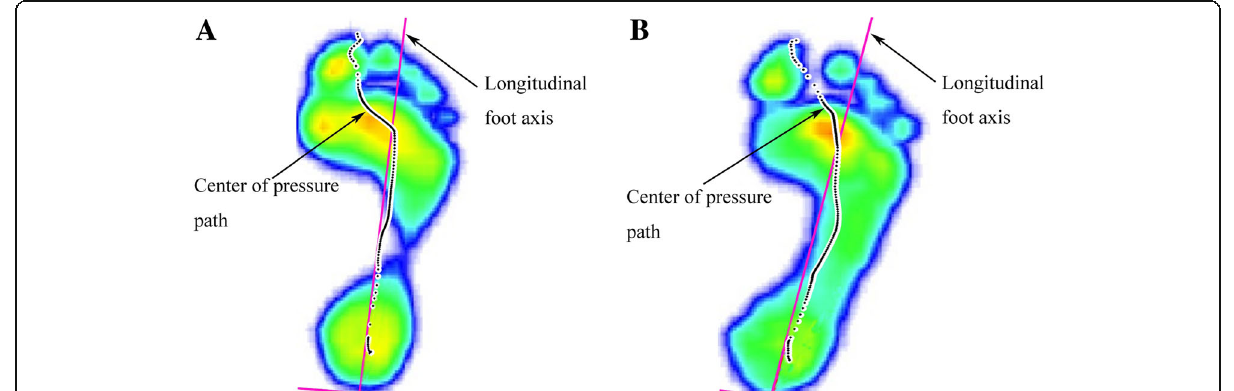
Fig. 2 Examples of COP of the high-arched ( a ) and normal-arched ( b ) feet